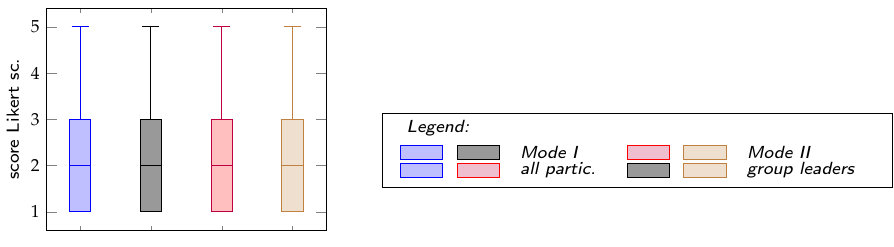
Figure 8. Response scores for pre-visit knowledge (K).